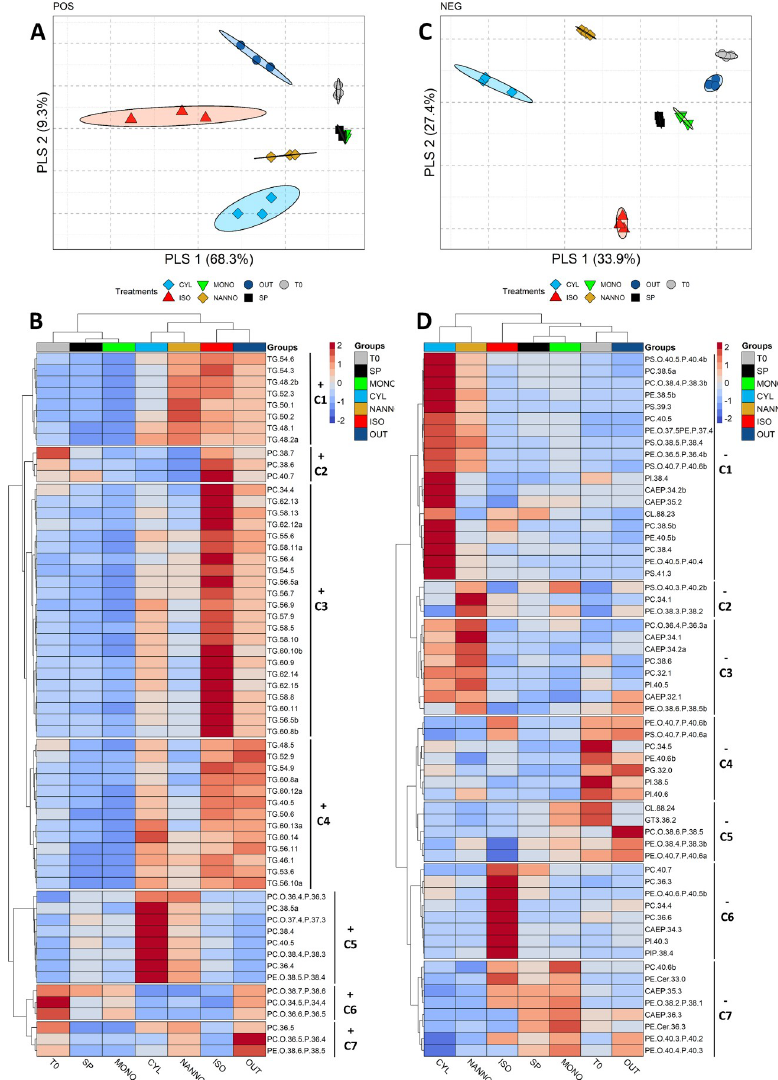
Fig 5. Partial least squares discriminant analysis (PLS-DA) plots of untargeted lipidomics data of the spat diet groups. A: Positive ionization mode. B: Heatmap plot reporting the group averages for Variable of important in projection (VIP) scores > 1 evidenced from POS lipidomics data. C: Negative ionization mode. D: Heatmap plot reporting the group averages for Variable of important in projection (VIP) scores > 1 evidenced from NEG lipidomics data. Heatmaps were plotted via ‘pheatmap’ package [72]. Main clusters evidenced by the elbow method ( S8C Fig ) are shown as breaks in the heatmap plot and are named as +/- (for POS/NEG) C and the relative cluster number (1 to 7). Euclidean distance was used as a distance measure, Ward as clustering algorithm. Lipids are reported as class, n˚ carbon and n˚ of double bonds (e.g. TG.58.10). Colour coding for lipid expression from Blue (Low) to red (High). For a representation of raw intensity for VIP selected lipids refer to S8D Fig .